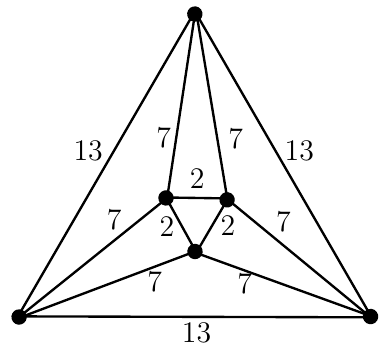
Figure 7: Construction of an integral octahedron graph.